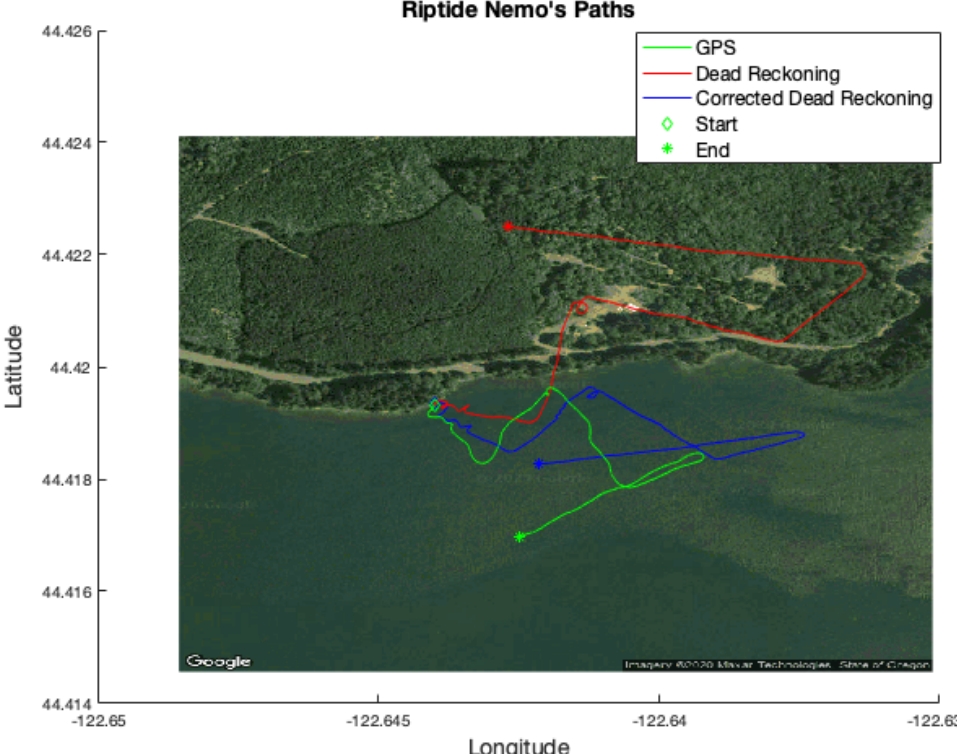
Figure 4. Correcting Nemo’s faulty compass. Ground truth GPS data (green line) were used to fit a quadratic polynomial curve to the faulty compass measurements that resulted in poor dead reckoning (red line). The GPS data were also used to determine a constant offset for the vehicle’s speed. This resulted in improved dead reckoning performance (blue